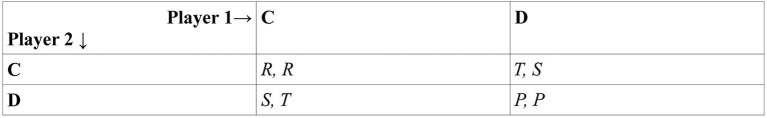
Payoffs accruing to (Player 1, Player 2) according to each player’s decision to cooperate (C) or defect (D) in a social dilemma are shown. R is the reward for mutual cooperation, T is the temptation to defect, S is the sucker’s payoff and P is the punishment for mutual defection. A game satisfies the assumptions of the prisoner’s dilemma where T > R > P > S. The snowdrift game is captured wherever T > R > S > P. Thus, the prisoner’s dilemma and the snowdrift game differ only in the best possible response to a partner’s defection: in the prisoner’s dilemma, the best response is to defect whereas in the snowdrift game, the best response is to cooperate.